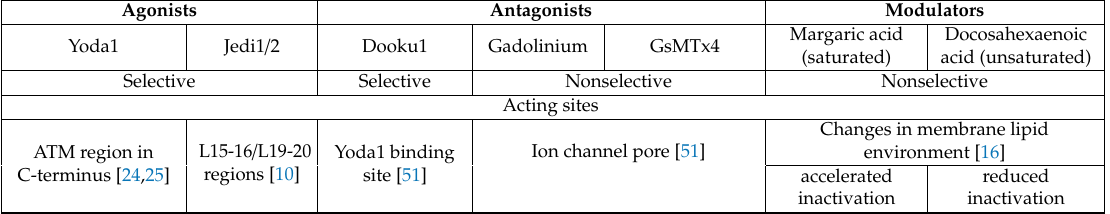
Table 1. Main agonists, antagonists and modulators of Piezo1